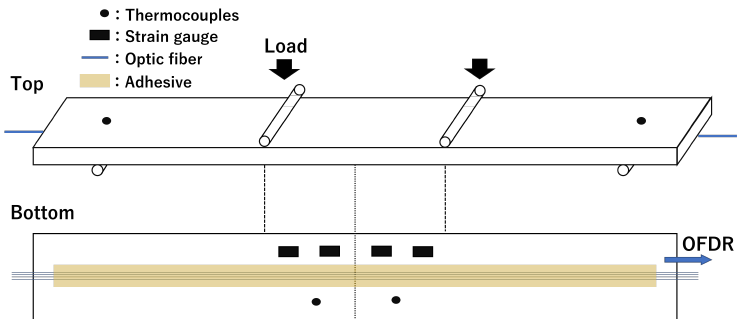
Figure 3. Schematic of the four-point bending test.